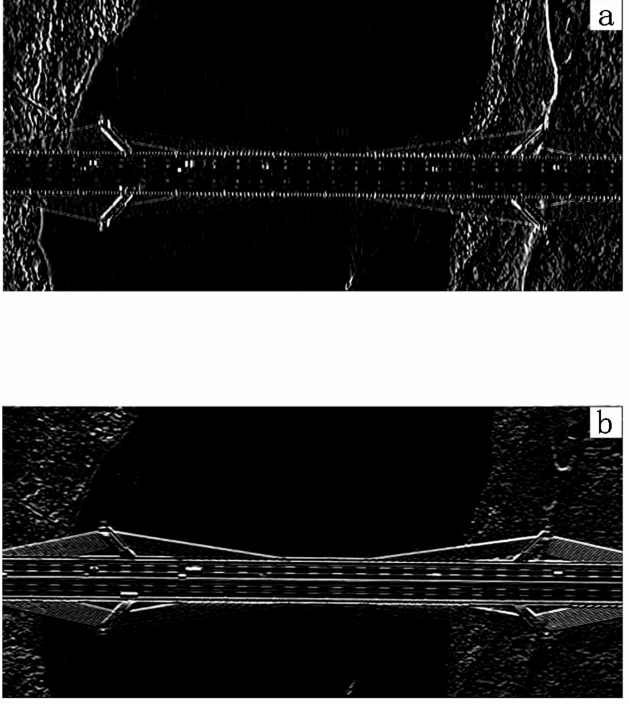
Figure 6. ( a ) Horizontal. ( b )